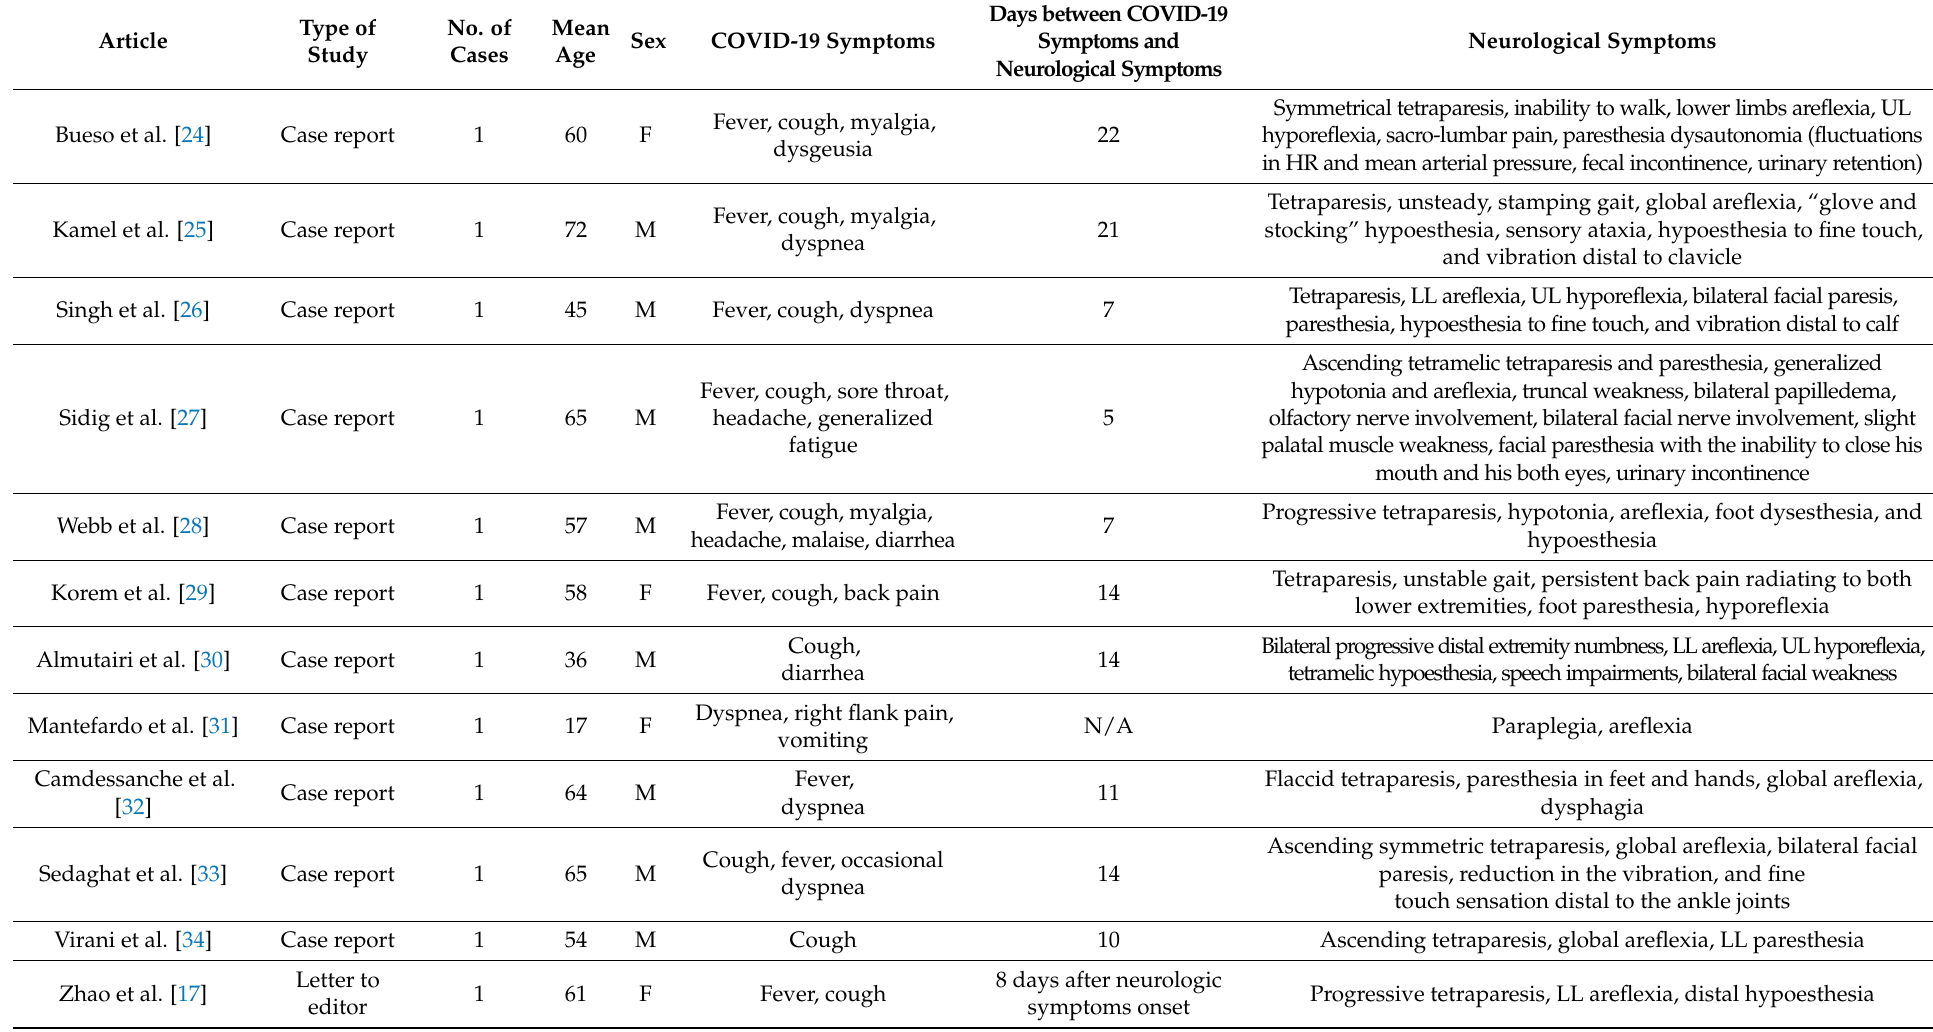
Table 4. Clinical features synopsis in